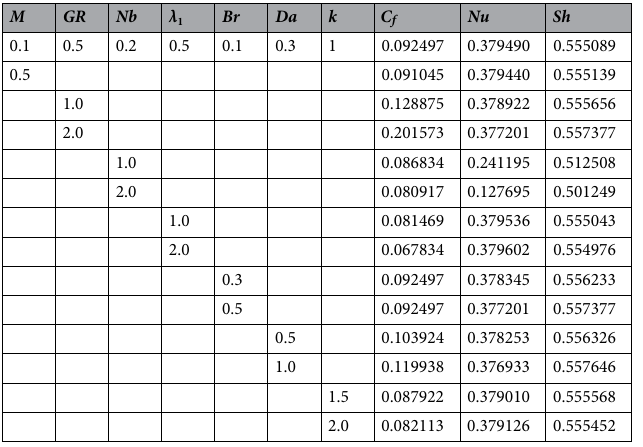
Table 1. Numerical values of the skin-friction coefficient, Nusselt number, and Sherwood number on the upper wall l 1 when x = 0.1.